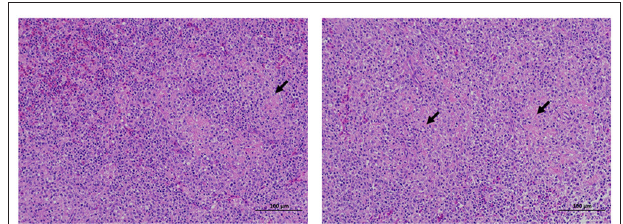
FIGURE 1 | Histopathological section results of tissues collected from clinically dead ducks. The tissues were fixed with 10% formalin, made into slices, HE stained, and observed under an optical microscope. The arrow shows the cells’ loss of cellular structure to eosinophilic homogeneous fibrous material in the spleen. The scale means 100 µ